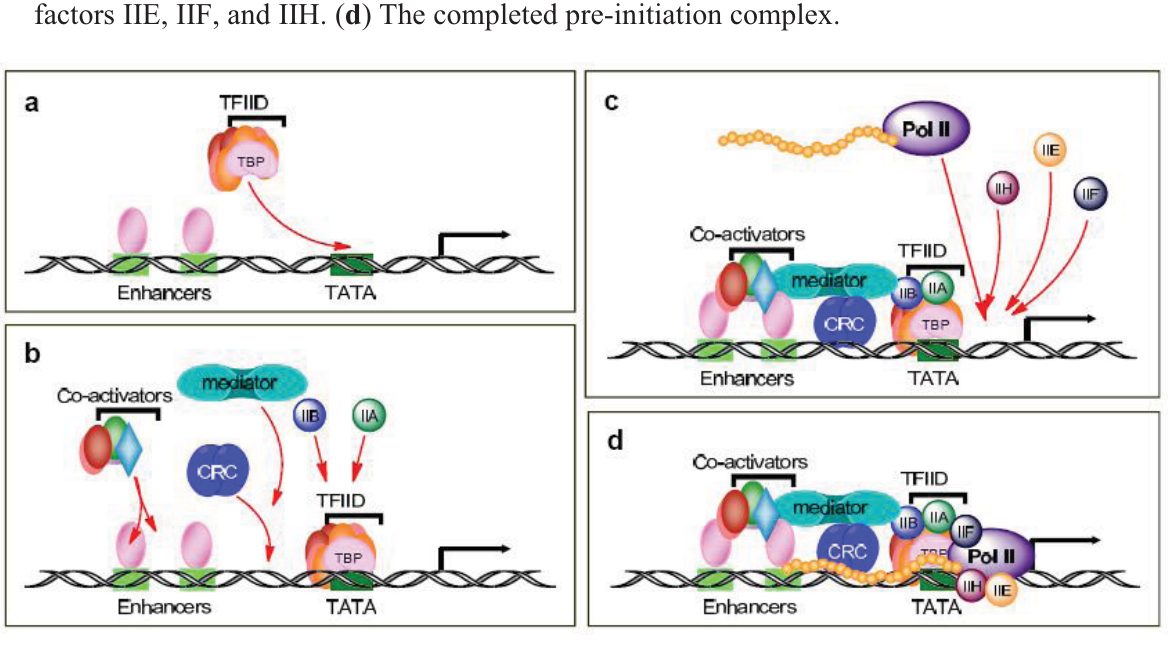
Figure 1. Schematic diagram of the formation of the pre-initiation complex. ( a ) Recruitment of transcription factor IID (TFIID). ( b ) Mobilization of mediator, chromatin remodeling complex (CRC), and other co-activators. ( c ) Recruitment of Pol II and the transcription factors IIE, IIF, and IIH. ( d ) The completed pre-initiation